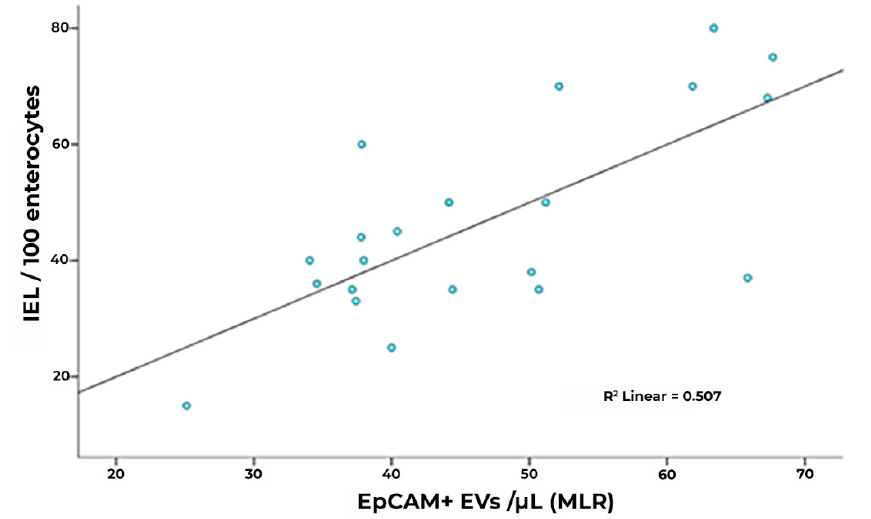
Figure 5. Correlation of IEL concentration and R model ‐ predicted EpCAM+ counts (unstandardized predicted value) in CD. In a multiple linear regression model including total, EpCAM+, and CD31+, CD45+ and CD41a+ counts, EpCAM+ EVs represent a statistically significant predictor (IEL: intraepithelial leukocytes).